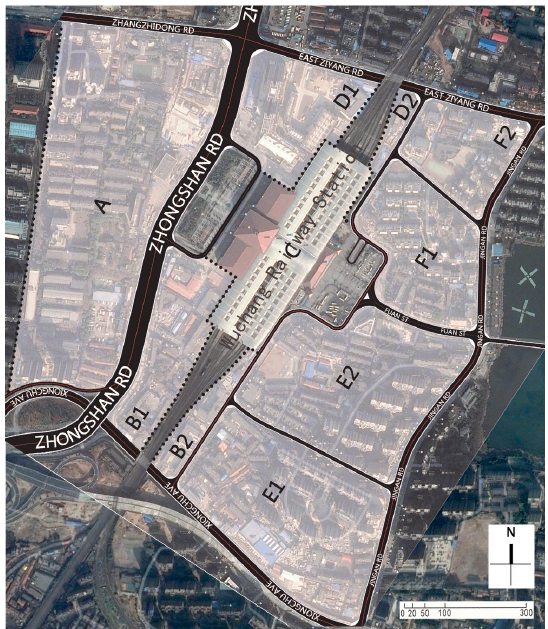
Figure 6. Ten-block zone for this study.